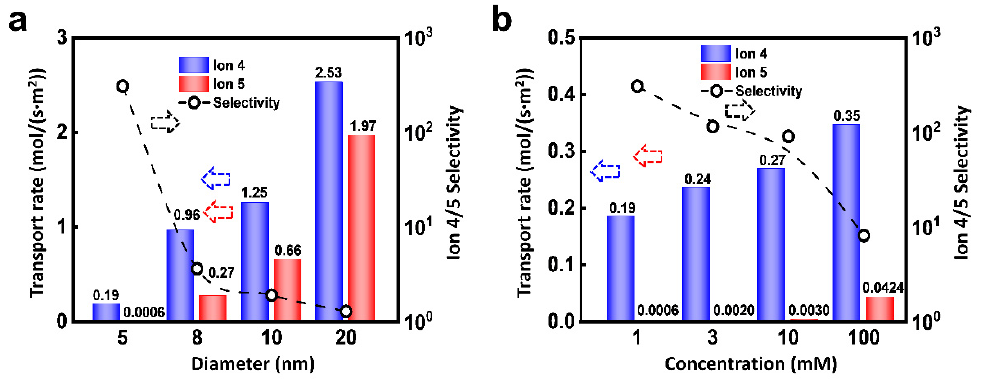
Figure 6. Effect of channel size and concentration. ( a ) Increasing channel radius can enhance the flux of ions, while it will lead to decreased selectivity; ( b ) An increase in ion concentration changes the thickness of the EDL, thereby affecting the migration of ions.